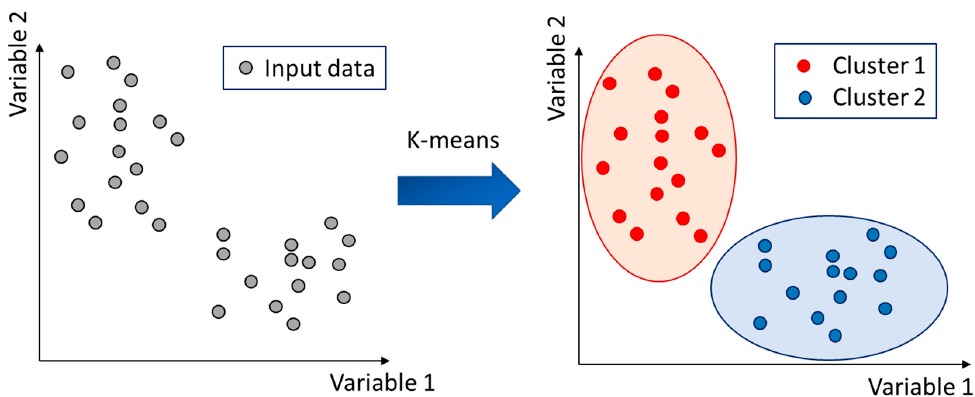
Figure 5. Illustrative example of k-means algorithm. In left graph, data are un-clustered and each point may belong to the cluster 1 or 2. In the right graph, the k-means clustered the data minimising the “within” distance and maximising the cluster centroid distance.